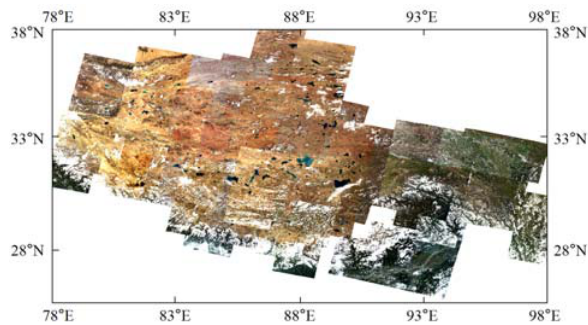
Figure 7. The DOMs of the involved 86 GF-1 WFV images In condition (2), the image positions of the tie-points are corrected with the distortion correction models, while in condition (1) they are not corrected. The root of mean squared error (RMSE) of the image residuals and the elevation residuals (the tie-points are constrained in elevation) in the block adjustment are listed in table 2. The statistic information shows that the RMSE of image-space residuals and elevation is remarkably reduced if the image-space coordinates are corrected by the distortion correction models.